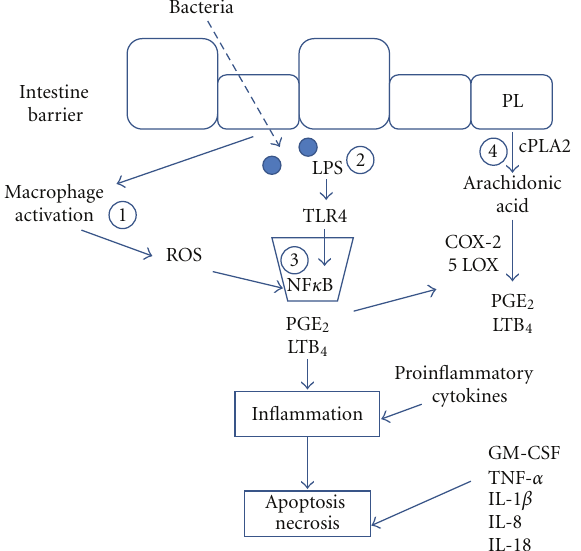
Figure 3: Inflammatory signaling cascade and mechanisms by which ganglioside protects the intestine from inflammation and injury. There are at least four possible mechanisms by which ganglioside protects intestine from injury: (1) gangliosides prevent proliferation, maturation and targeting of immune cells; (2) gan- gliosides bind enterotoxic LPS and prevent interaction with TLR4; (3) gangliosides inhibit NF κ B activation; and (4) gangliosides prevent production of LTB 4 and PGE 2 . Adapted from Schnabl et al. [29]. COX-2 = cyclooxygenase-2; cPLA2 = cytosolic phospholipase A2; LTB 4 = leukotriene B 4 ; LPS = lipopolysaccharide; 5 LOX = 5 lipoxygenase; PGE 2 = prostaglandin E 2 ; PL = phospholipid; ROS = reactive oxygen species; 1, 2, 3, 4 = steps inhibited by ganglioside; TLR4 = toll-like